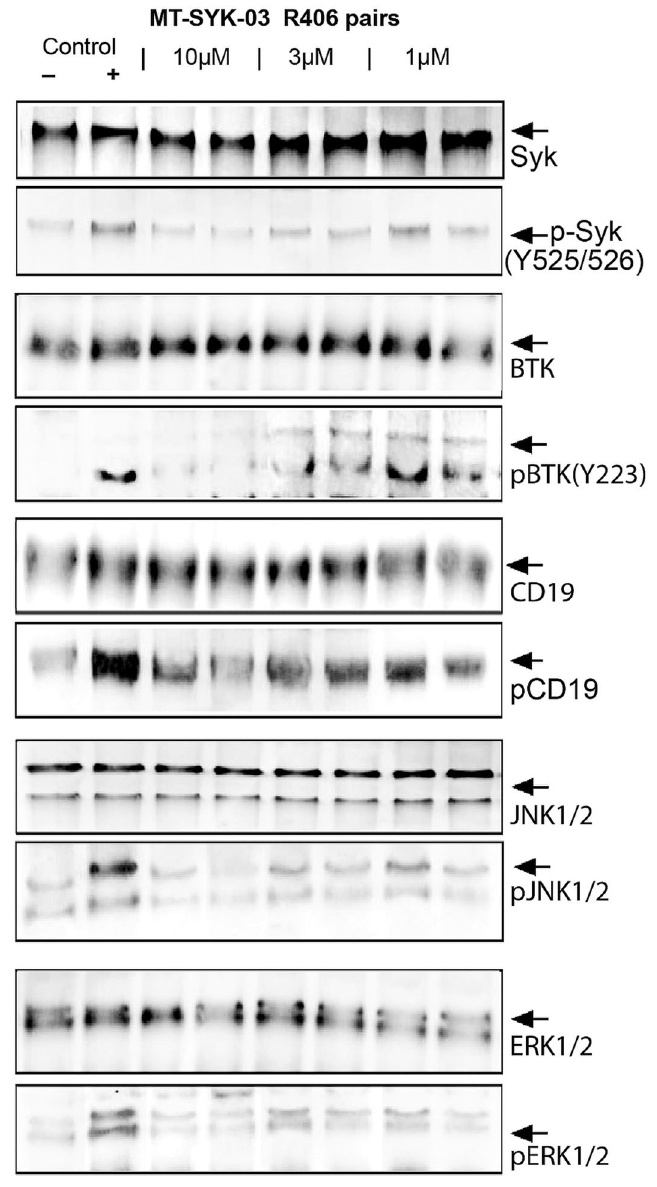
Figure 3. Effect of the MT-SYK-03 and a reference compound (R406, right hand side of each pair) on phosphorylation of the main modulators of the B-cell cascade development (tyrosine kinases Syk, BTK, as well as CD19 receptor) and effector kinases of mitogen/stress-activated signal cascade (JNK1/2 and ERK1/2). Cropped image from different blots is presented, as indicated by borders. Each section corresponds to a different